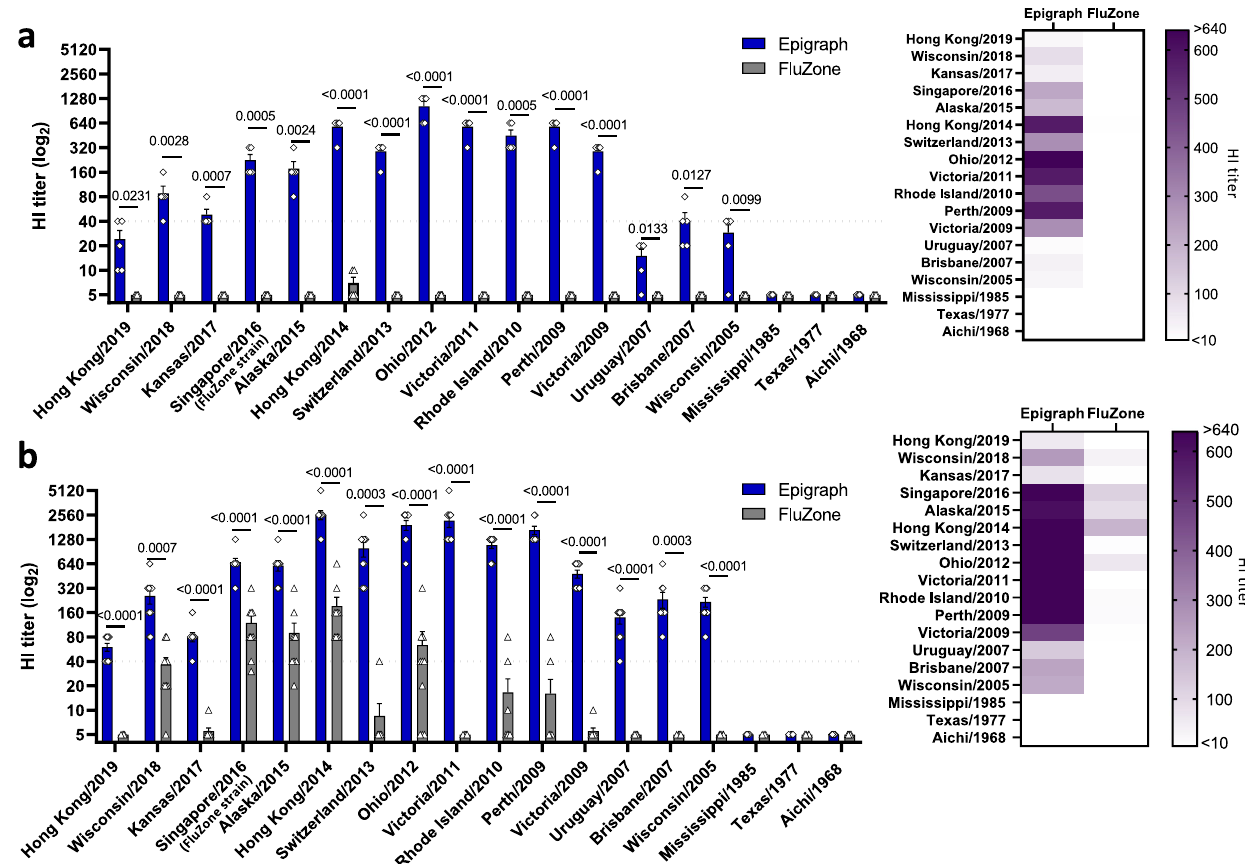
Fig. 2 Epigraph immunization induces cross-reactive antibody responses in mice against a panel of 18 representative H3 viruses. BALB/c mice were vaccinated with 10 10 vp of HAdV-5-Epigraph and compared to FluZone-vaccinated mice. Antibody responses were measured using a HI assay against the 18 H3 representative strains for both a single immunization ( a ) or after boosting ( b ). A heat map of these HI titers was constructed to further visualize the total cross-reactive antibody response of each vaccine. Data are presented as the mean with standard error (SEM) (single immunization n = 5; prime boost n = 10; unpaired T